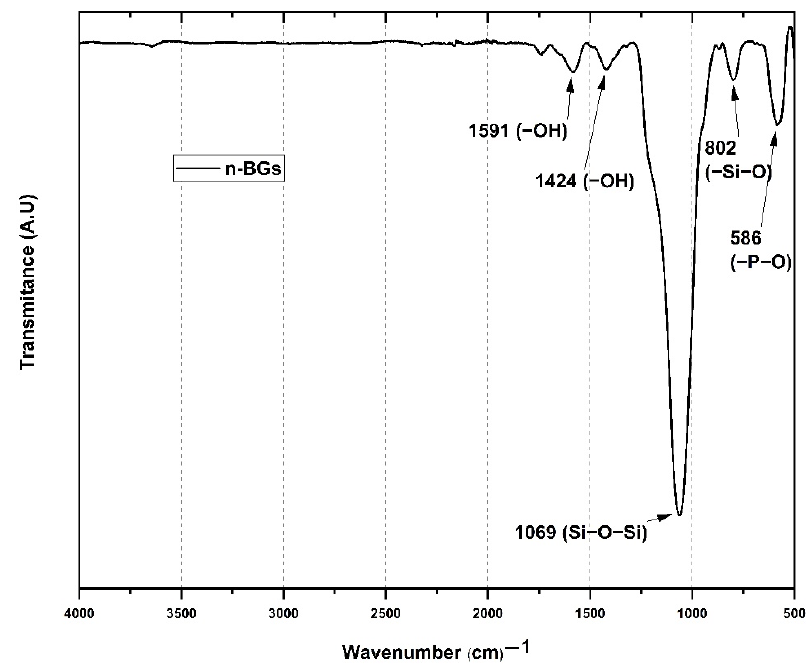
Figure 1. FT − IR spectrum for the n − BGs.